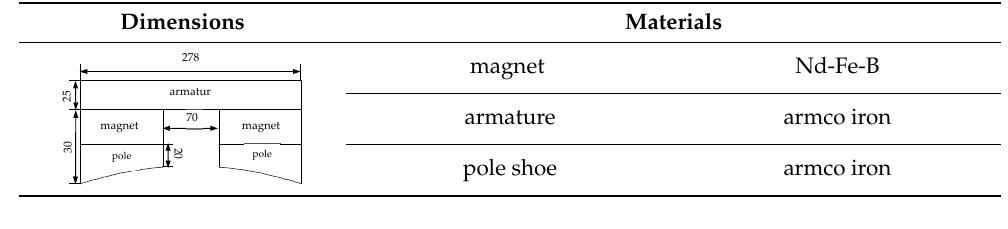
Figure 6. Excitation structure model.